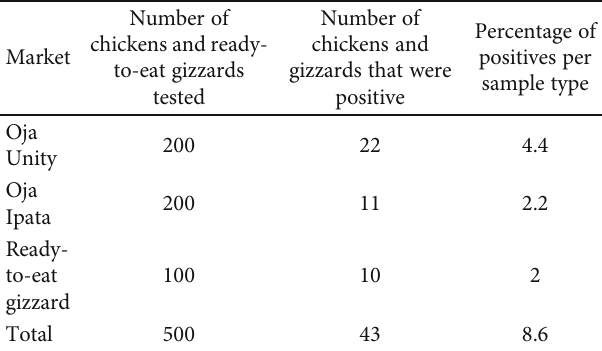
Table 2: Salmonella isolation from the intestinal content samples from Oja Unity and Oja Ipata and ready-to-eat chicken gizzard samples in the Ilorin